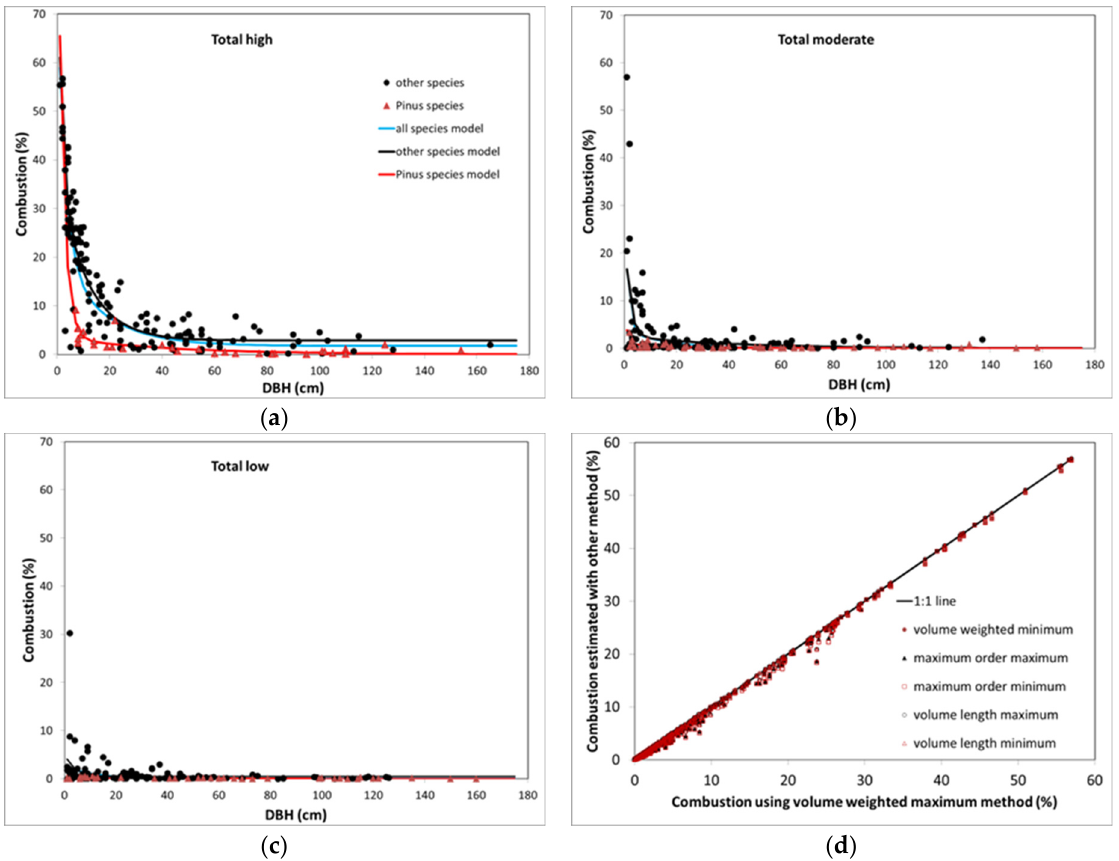
Figure 3. Total aboveground consumption as a function of fire severity and diameter at breast height (DBH) at Rim and Creek fires in California’s Sierra Mountains: ( a ) high severity; ( b ) moderate severity; ( c ) low severity; and ( d ) estimates of total combustion using other methods when compared to estimates weighting branches by volume and assuming maximum bole scorch.